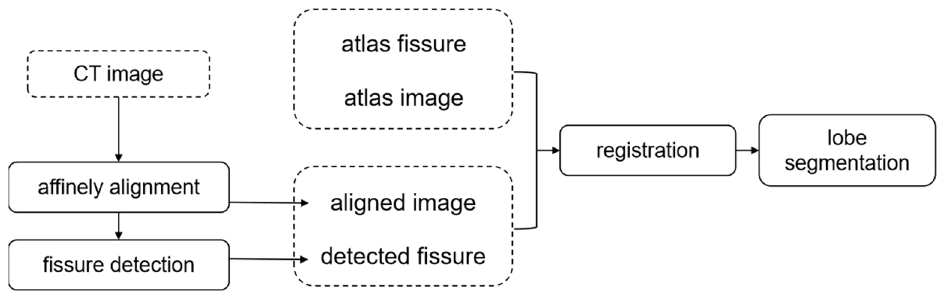
Figure 1. Overview of the fissure-aided lung registration method for lobe segmentation.